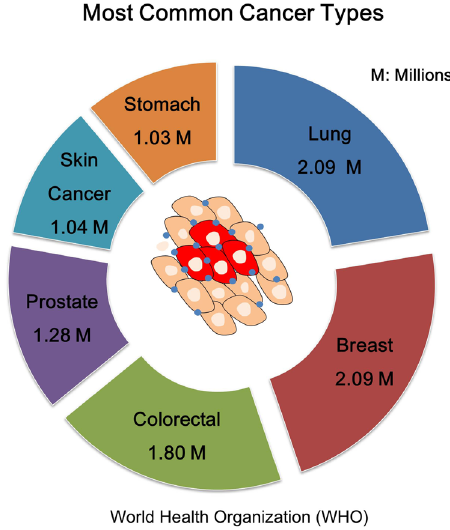
Fig. 1 Cancer types and number of patients. Cancer, a leading cause of death worldwide accounted for an estimated 9.6 million deaths in 2018. The most common types of cancer and the number of affected patients are mentioned. (Source: World Health Organiza- tion (WHO)).